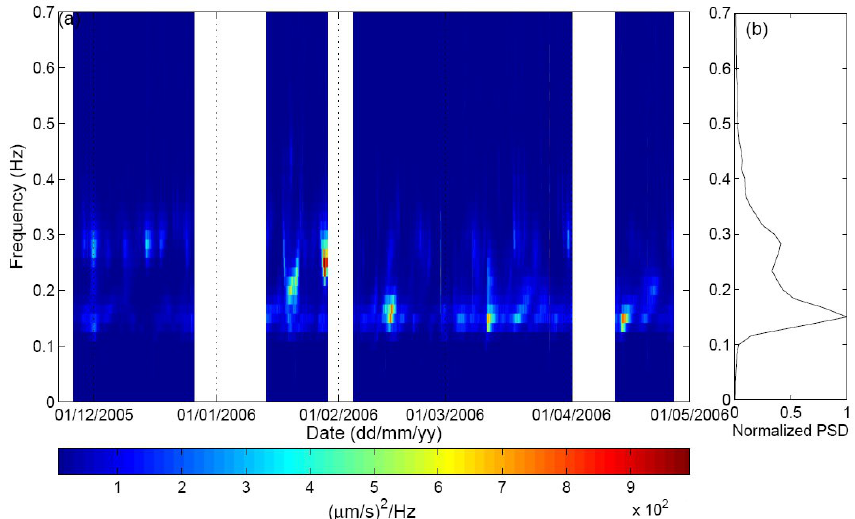
Fig. 3. (a) Power spectra (computed by the fast Fourier transform and averaged over 20-min time-intervals) of the North-South component of COCA as function of time. Horizontal colour bar indicates the correspondence between the colours and the power spectra. (b) Mean normalized power spectra obtained by averaging the spectra computed in the 60s time-windows over all the data set and dividing by the maximum value. The principal results do not depend on the station nor on the ground motion component.